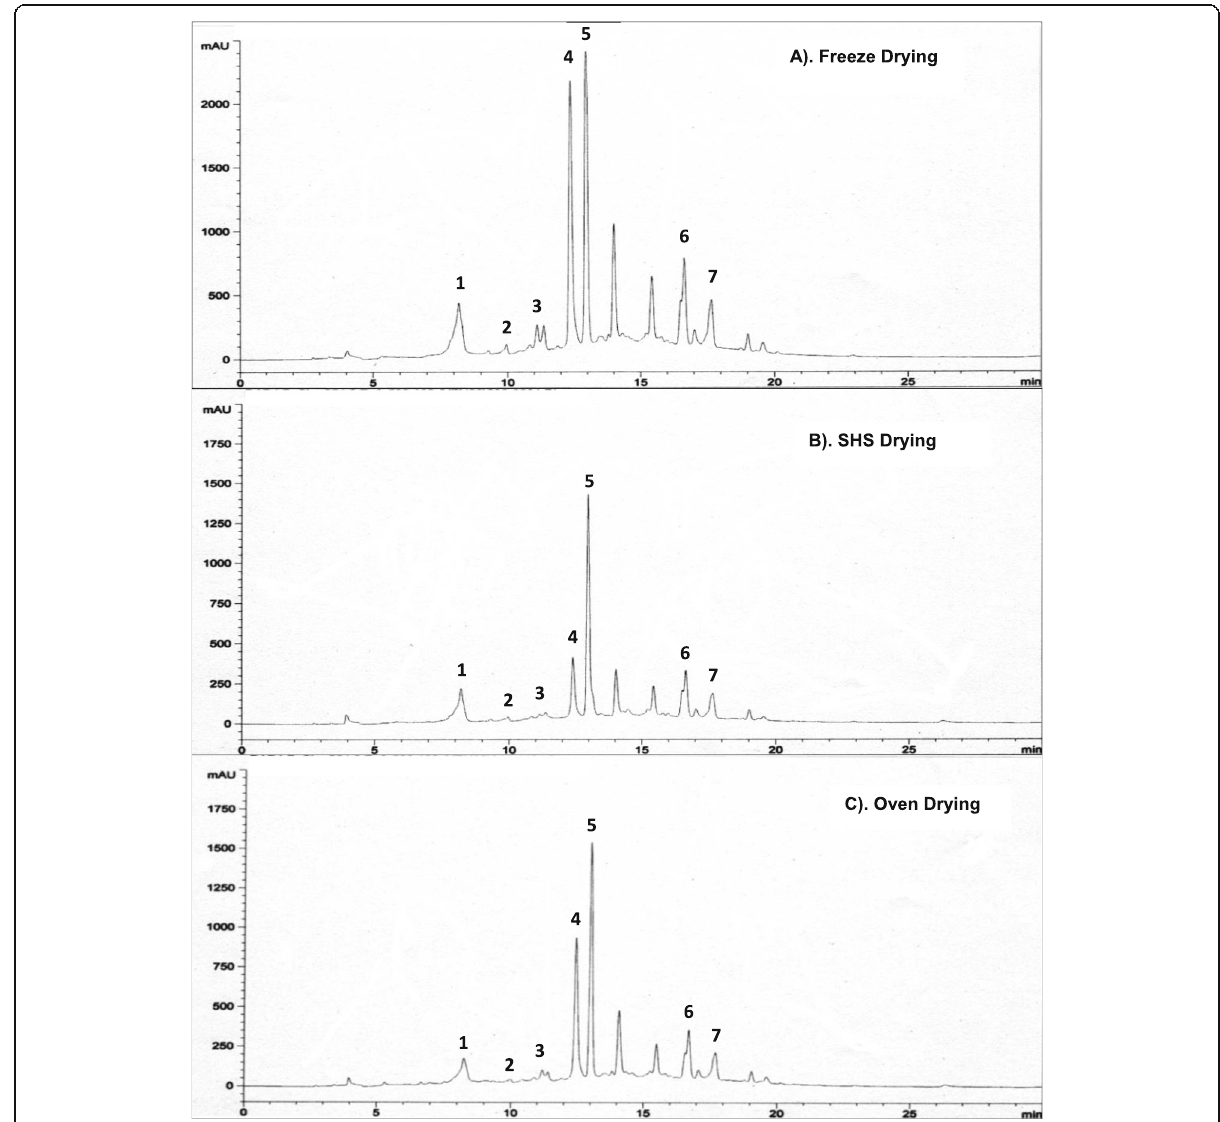
Fig. 1 HPLC Chromatogram of Tea Leaves Dried Using ( a ) Freeze Drying, ( b ) SHS Drying, and ( c ) Oven Drying Methods. Peaks: (1 = gallic acid), (2 = theobromine), (3 = epicatechin), (4 = epigallocatechin gallate (EGCG)), (5 = caffeine), (6 = rutin), (7 = myricetin). (SHS = Superheated steam) Table 2 List and concentration of selected compounds detected in tea [ Camellia sinensis (L.) Kuntze] using HPLC Peak No. Retention Compound Concentration (mg per g DW) Time (min) Name